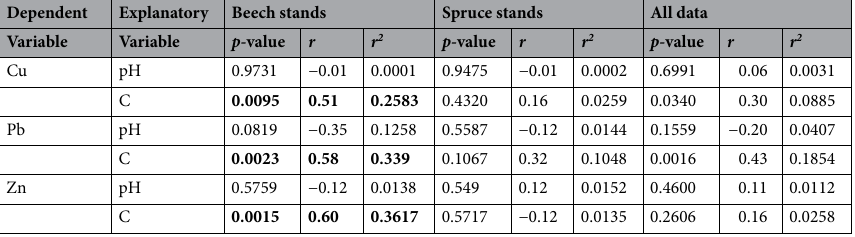
Table 1. Linear regression models of soil properties and PTEs contents for beech and spruce stands and for the whole dataset; bold values indicate strong positive correlations ( r > 0.5) that were significant at p =